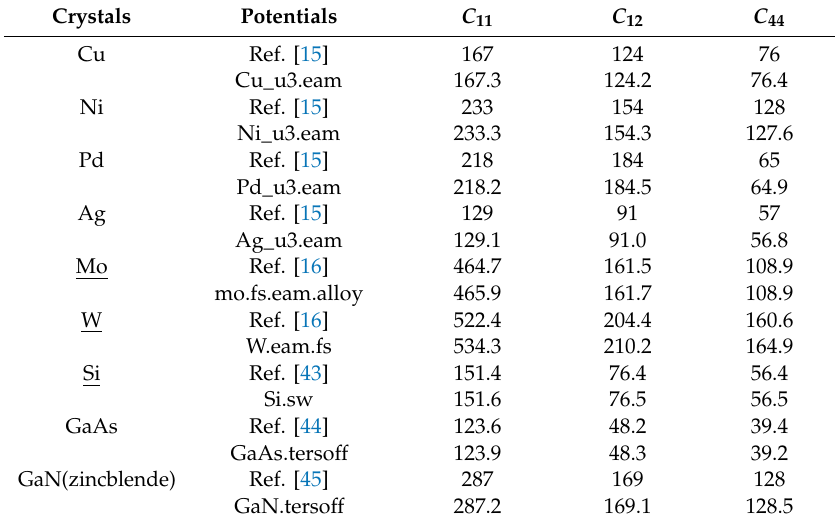
Table 1. Bulk elastic constants of cubic crystals (unit: